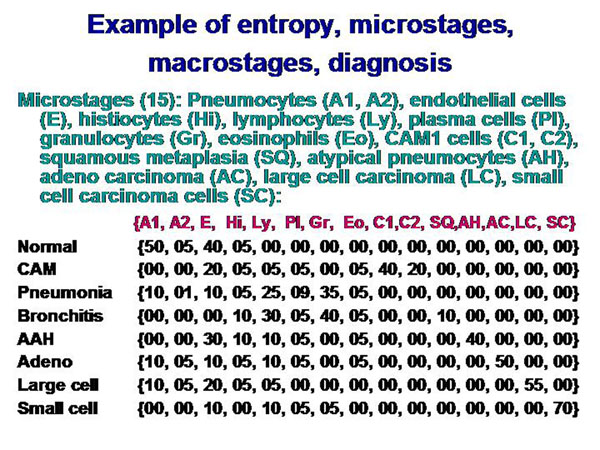
Explanation of used cell types and their assumed relative frequency in the macrostage